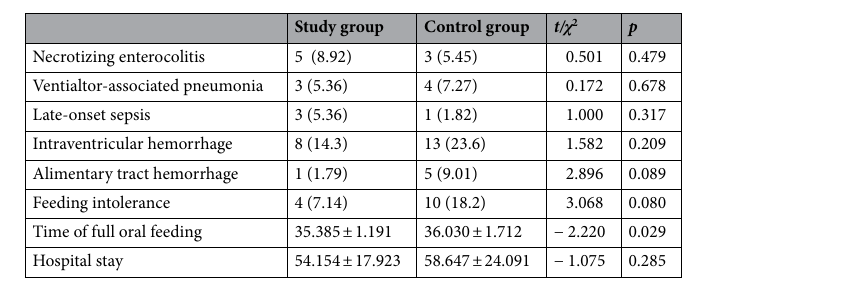
Figure 2. Association of sIgA with oropharyngeal administration of mother’s milk, mode of delivery, gestational age at birth. The graphs sequentially represent the 95% confidence intervals and beta values of the regression coefficients for oropharyngeal administration of mother’s milk, mode of delivery, gestational age at birth.